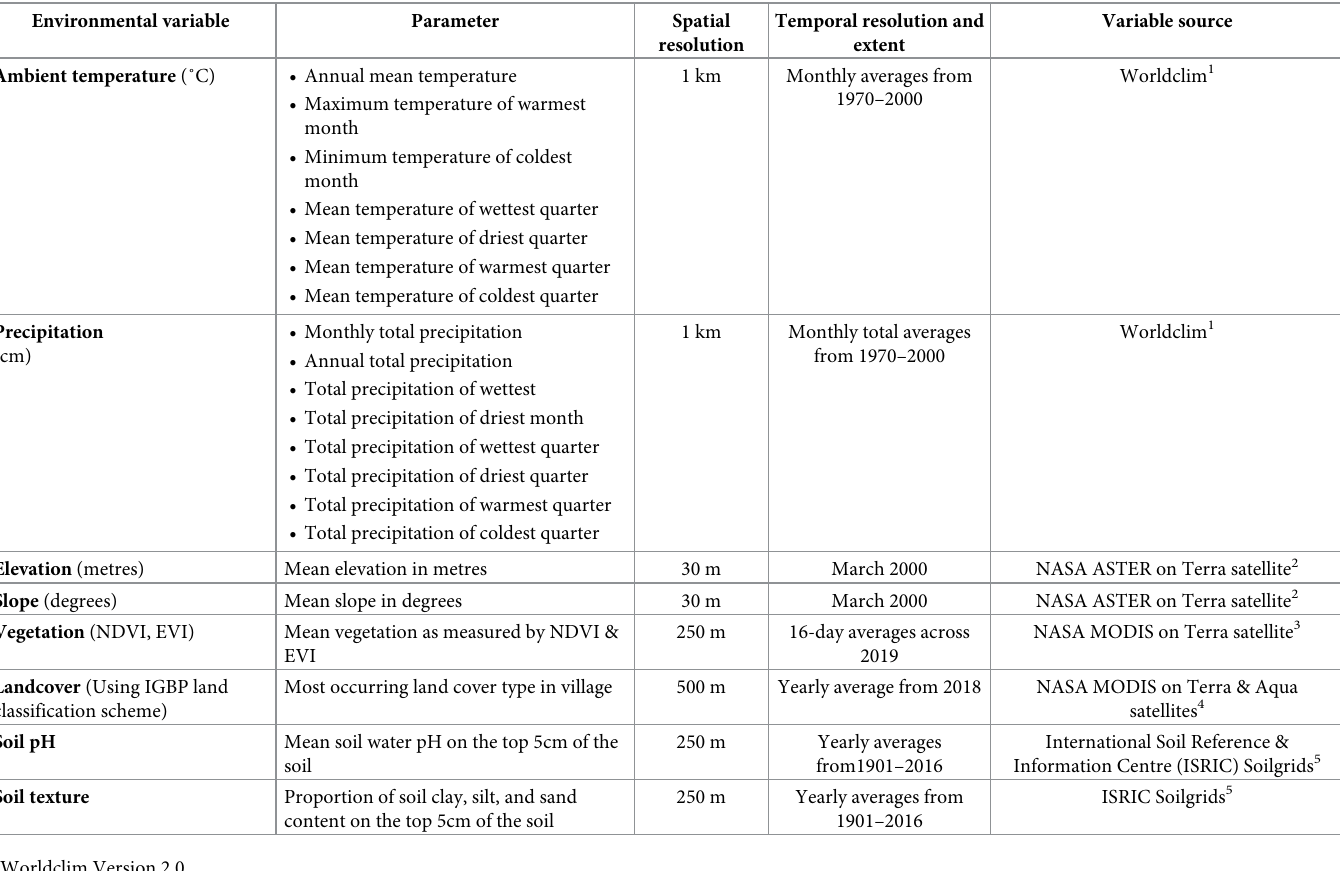
Table 1. Environmental variables extracted for the current